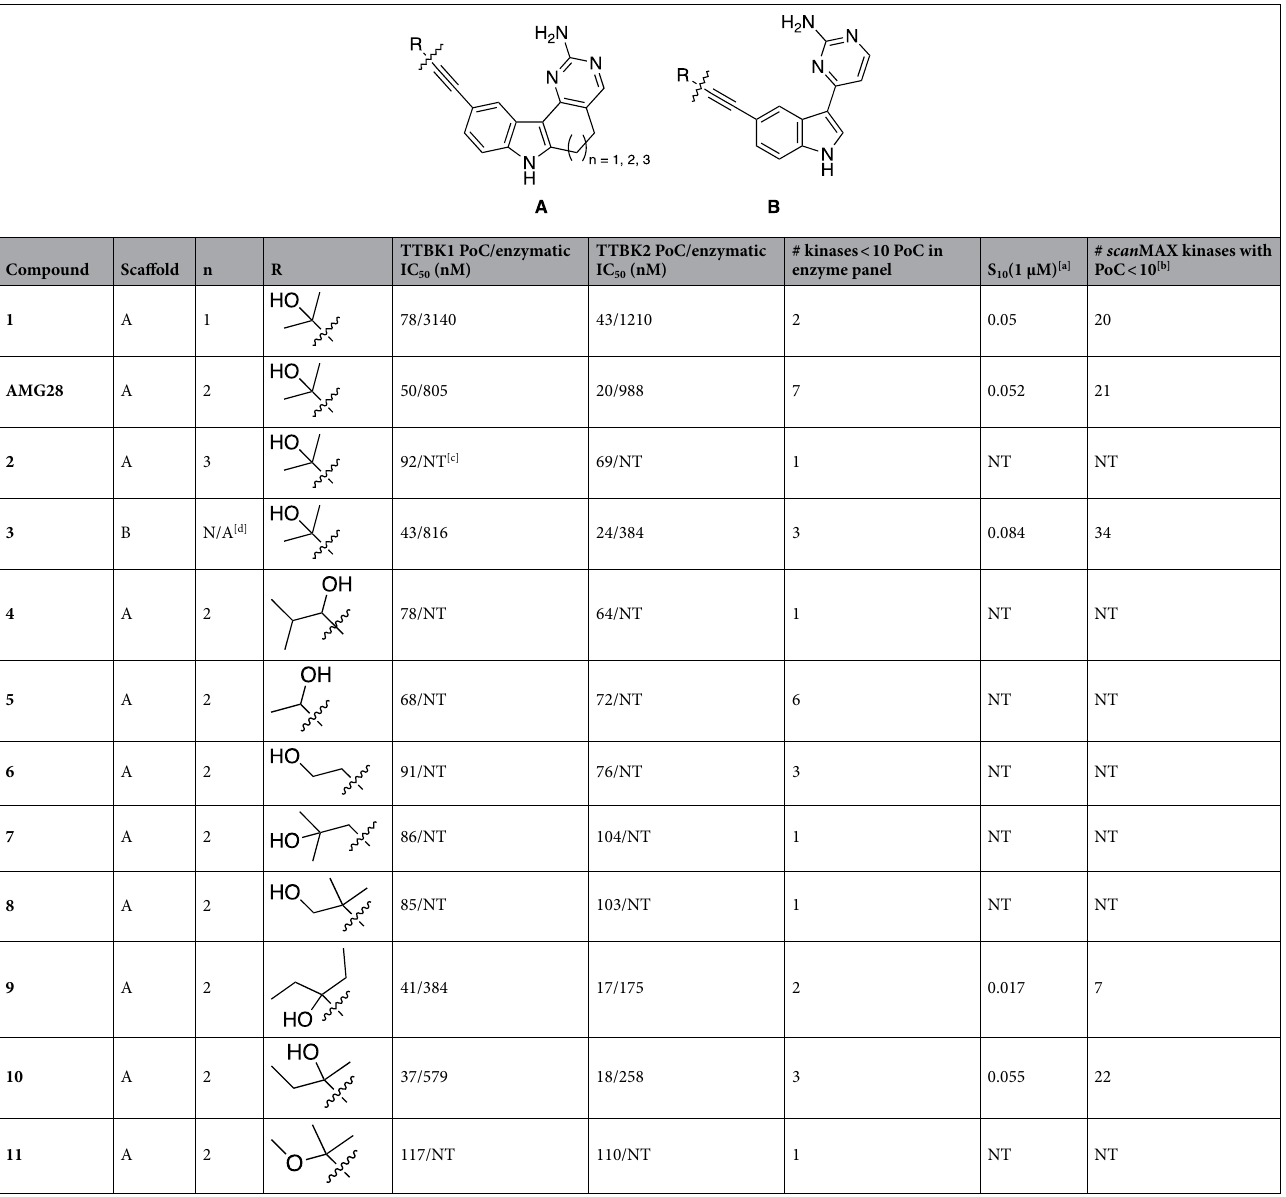
Table 1. Kinase panel profiling of indolyl pyrimidinamine library. a S 10 (1 μM): percentage of screened kinases with percent of control (PoC) values < 10 at 1 μM. b Number of kinases with PoC values < 10 at 1 μM. c NT: not tested. d N/A: not